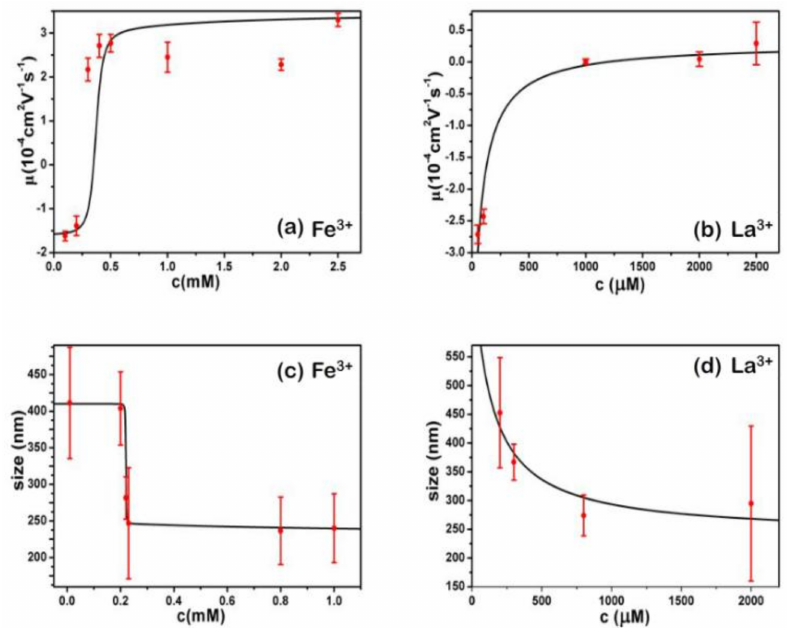
Figure 5. Electrophoretic mobilities and particle sizes of DNA-complex by Fe 3+ ( a , c ) and La 3+ ( b , d ) fitted by cooperative Zimm–Brag and simple two-state model,